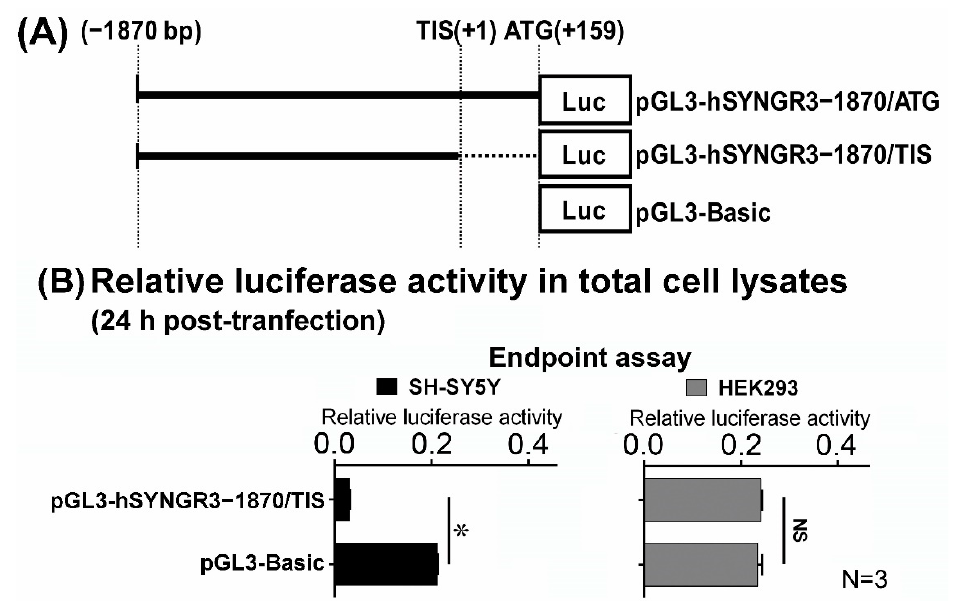
Figure 3. Promoter activity of –1870 bp to the ATG of the SYNGR3 gene as measured by luciferase reporter assays. ( A ) Schematic diagram of the pGL3-Basic and pGL3-hSYNGR3–1870/TIS constructs. ( B ) End point (24 h post-transfection) luciferase activity of pGL3-Basic and pGL3-hSYNGR3–1870/TIS constructs in SH-SY5Y and HEK293 cell lysates. * p < 0.05 represents the statistical significance between the two designated groups by the unpaired Student’s t -test.